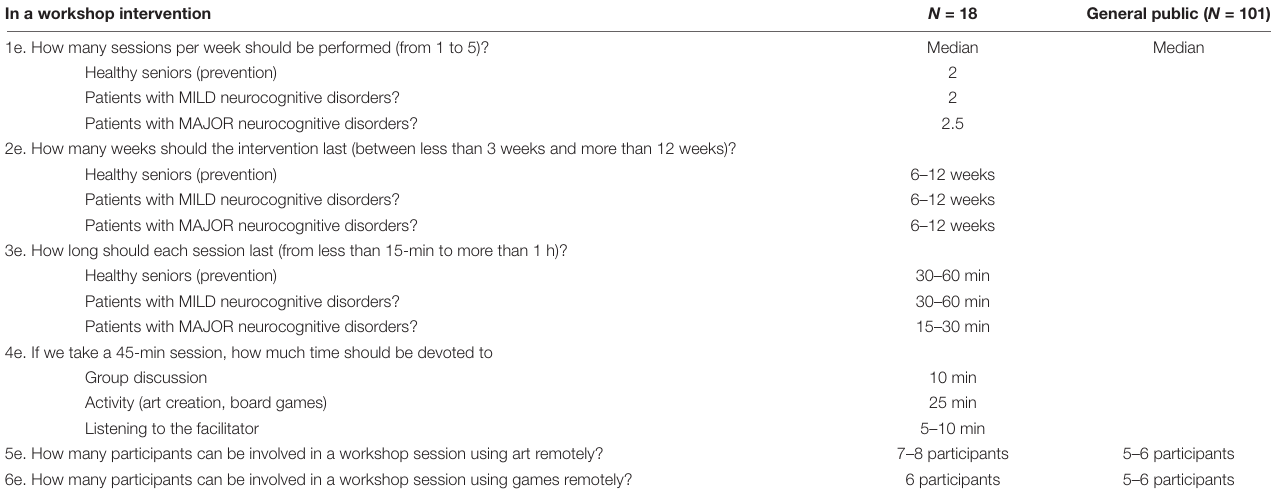
TABLE 2 | Delphi round 1 and 2 questions for the experts on the organizational aspects of workshops. In a workshop intervention